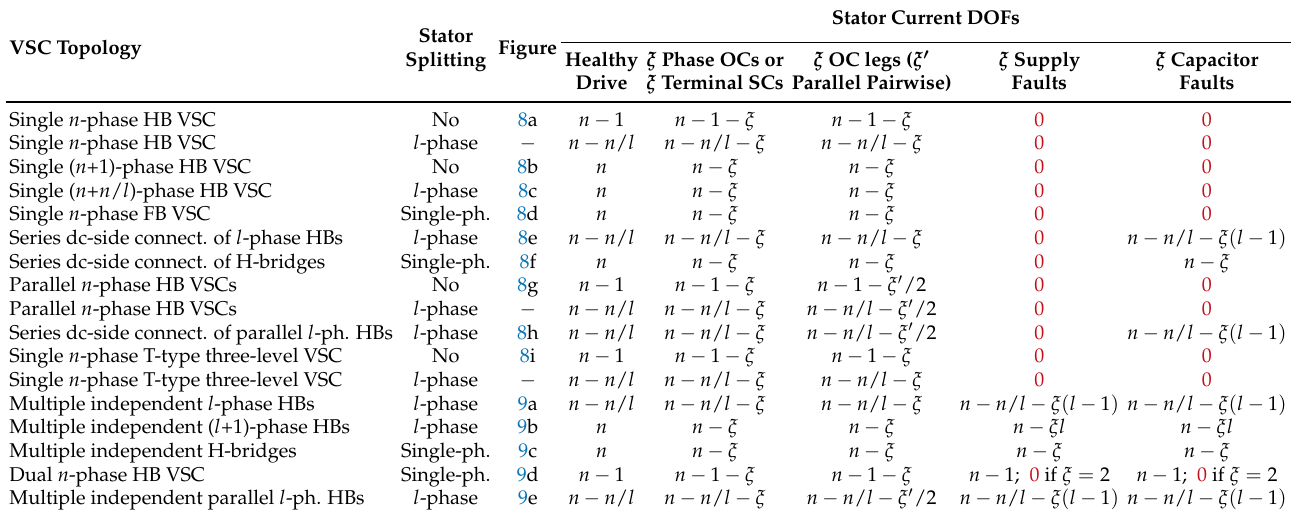
Multiple independent H-bridges Single-ph. 9c n − ξ